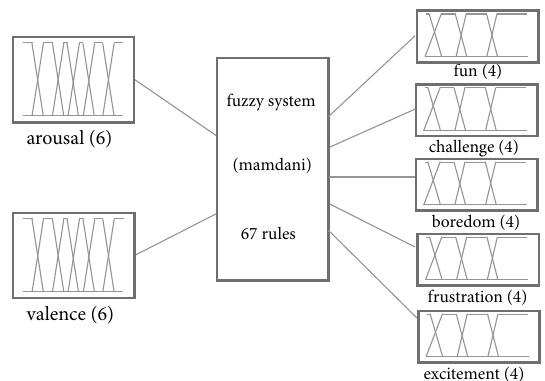
Fig. 6. Fuzzy system by (Mandryk, Atkins 2007) for the recognition of five emotional states (fun, challenge, boredom, frustration, and excitement) from arousal and